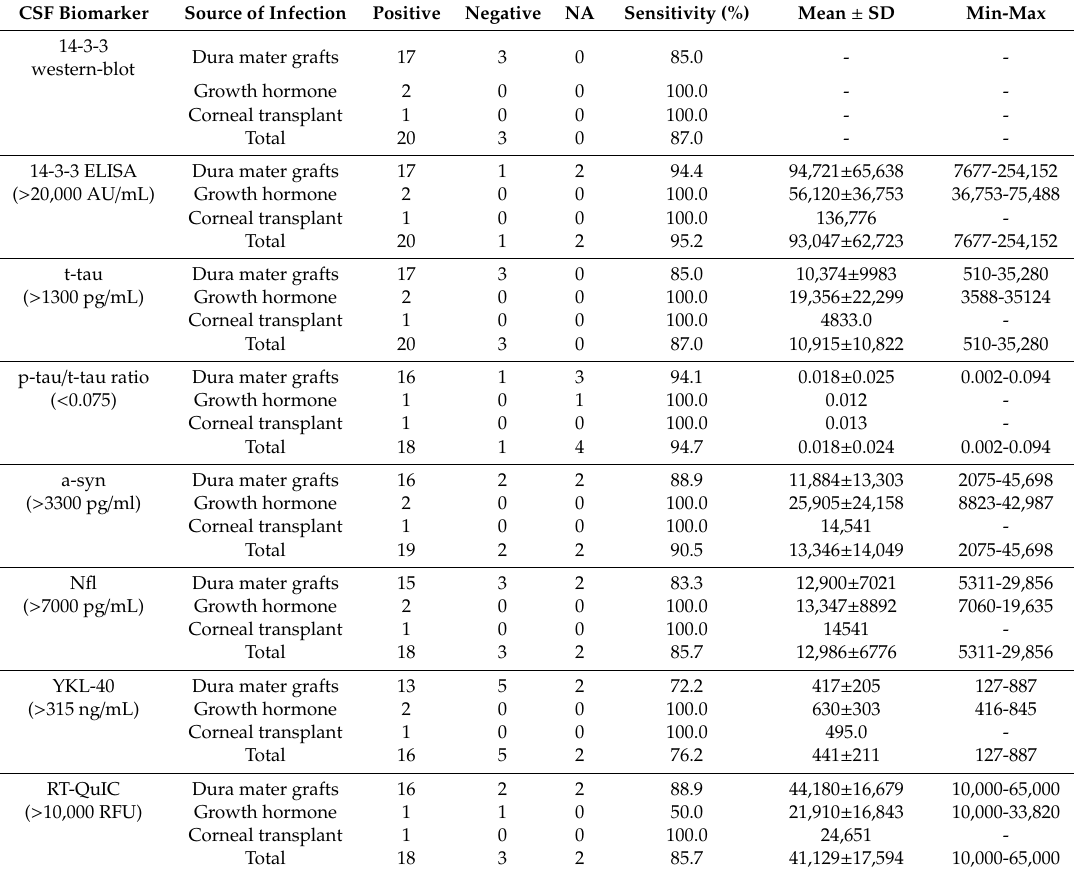
Table 3. Cerebrospinal fluid biomarkers in iatrogenic CJD. Cerebrospinal fluid (CSF) biomarker with cut-o ff point, source of infection, biomarker outcome given as positive, negative, or not available (NA), sensitivity of the biomarker test (%) with concentrations (mean with standard deviation (SD)), and minimum and maximum values are indicated. Data stratification based on infection source are only disclosed as descriptive information but no subgroup analysis was